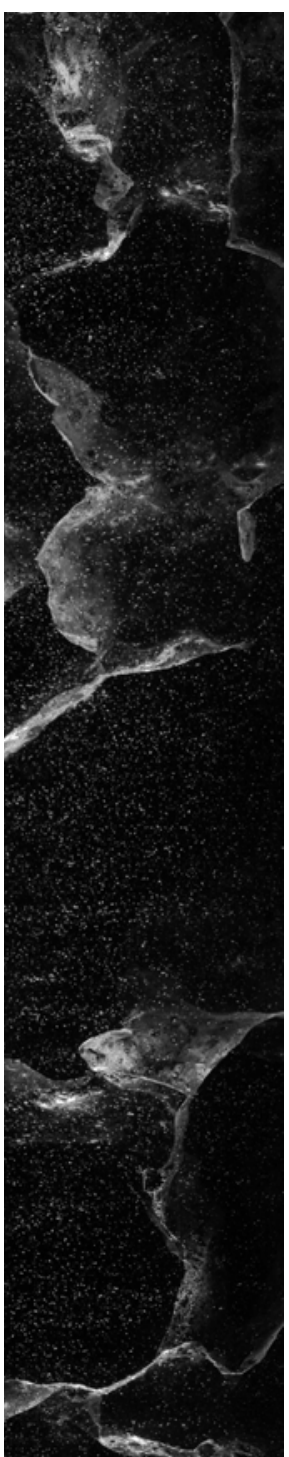
Fig. 2. Image of a section of sample “A” from 3070.10–3070.40m depth (bag 5583). The slab is 3.4cm thick and 6cm wide. Ice crystals are rather large for Greenland: up to 10cm across and grain boundaries are visible. This is due to the high temperature and very active crystal dynamics in the deepest part of the ice that is almost at the pressure melting